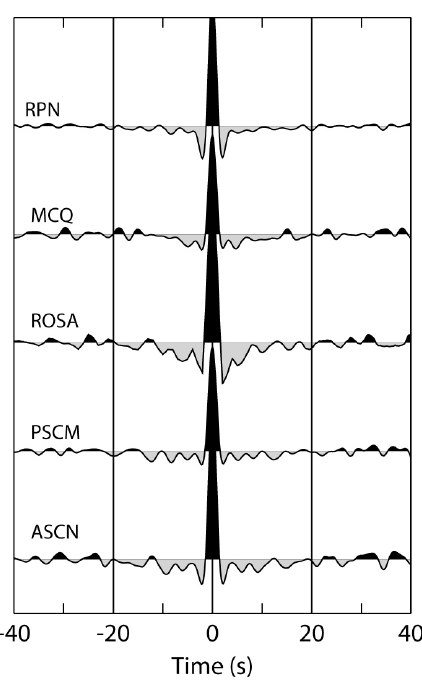
Figure 3. Stacked L-component receiver functions at different sta- tions that essentially indicate the P -wave at zero